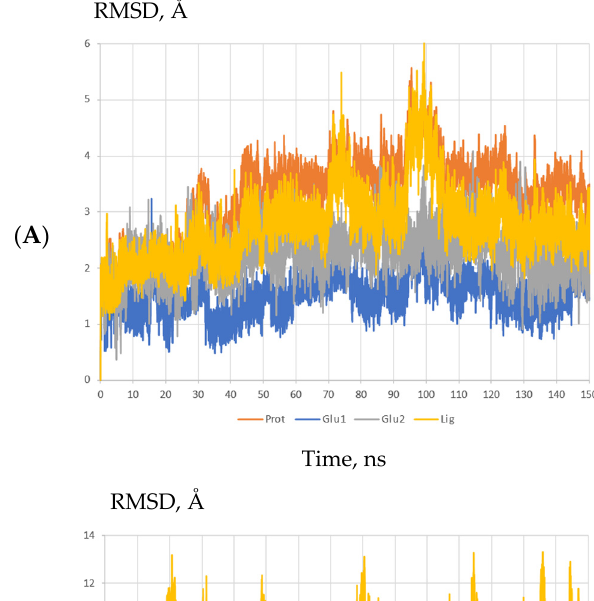
Figure 5. Binding mode of the NAM 1j , refined using molecular dynamics simulation (150 ns). ( A ) General view of the dimeric ligand binding domain of AMPA receptor (GluA2) and location of the binding site. ( B ) Binding pockets in the protein molecular surface colored by local hydropho ‐ bicity (brown for hydrophobic and blue for hydrophilic). ( C ) Detailed view of the binding site. The ligand is represented by a grey ball ‐ and ‐ stick model, the amino acid residues located within 3 Å of it are represented by pink stick models.